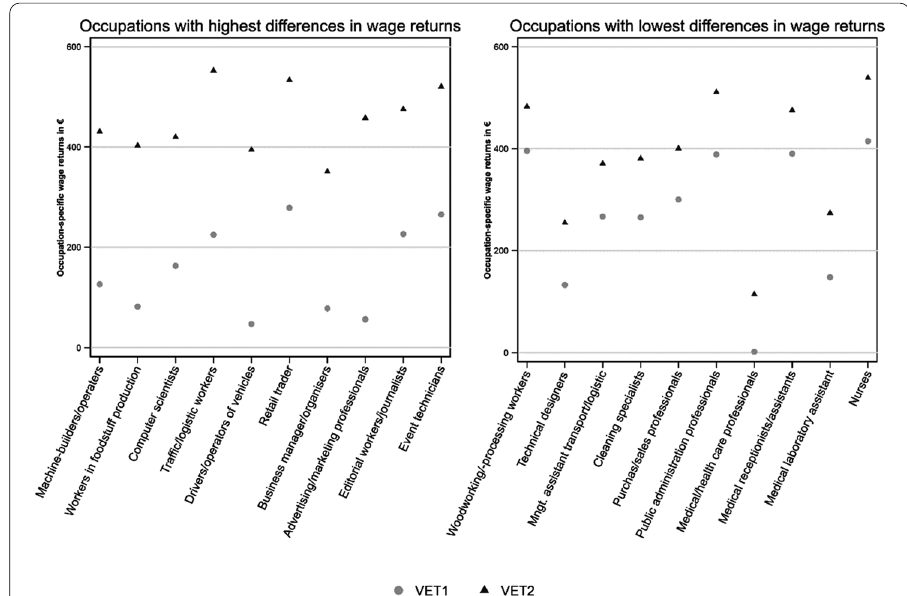
Fig. 4 Highest and lowest differences in occupation-specific wage returns in euro (Source: BIBB/BAuA Employment Survey 2018. Population: German employees)